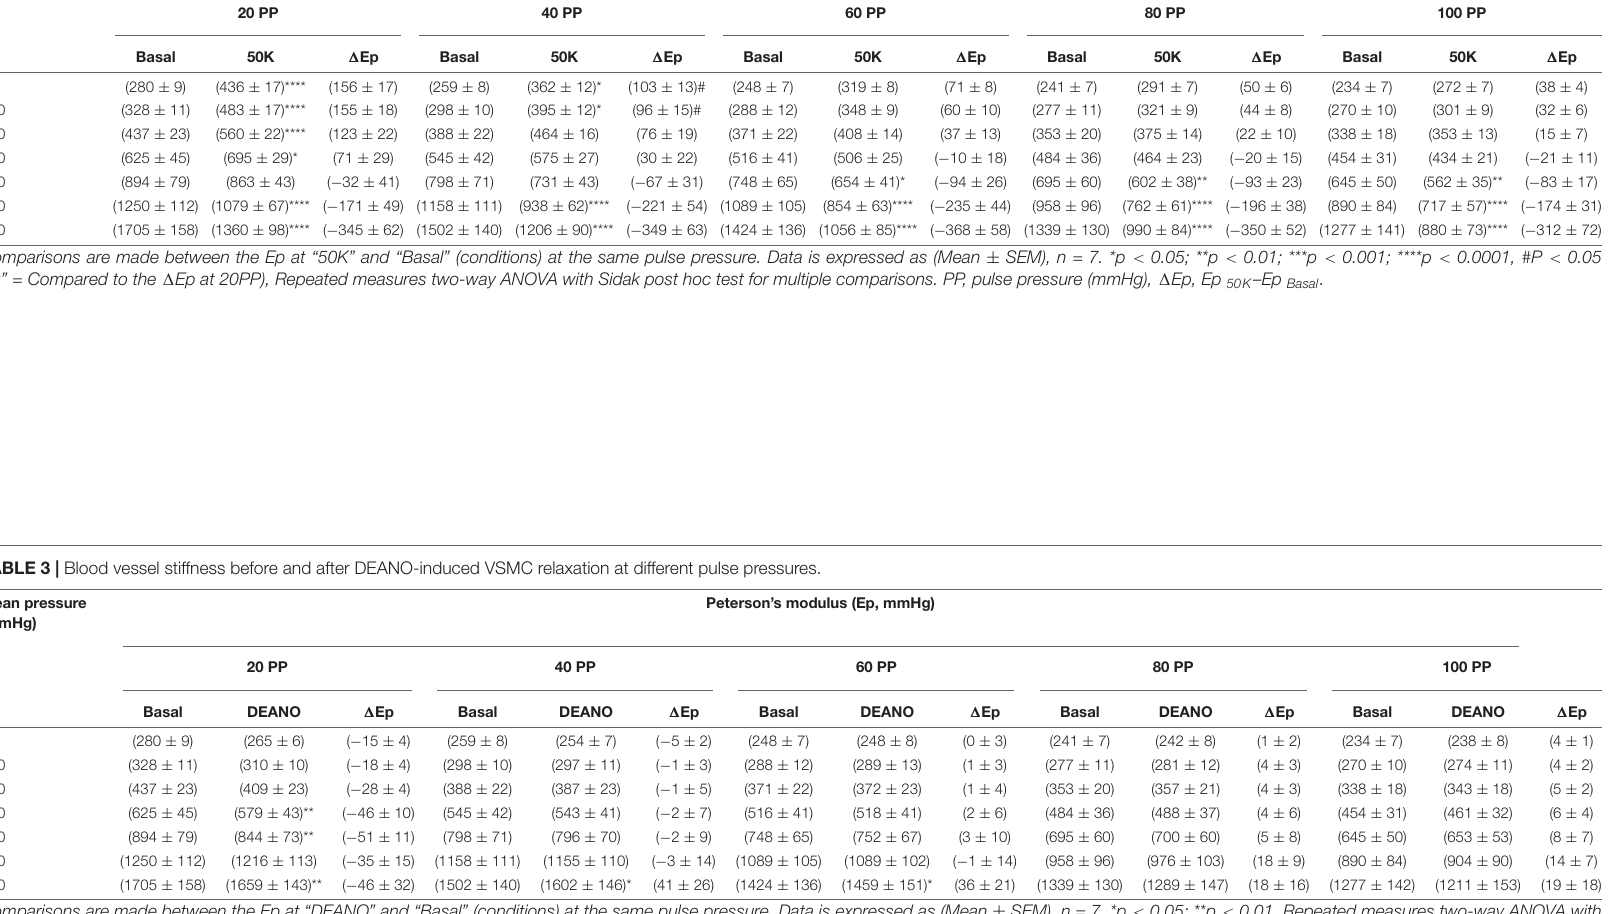
TABLE 2 | Blood vessel stiffness before and after 50 mM KCl induced VSMC contraction at different pulse pressures. Mean pressure (mmHg)